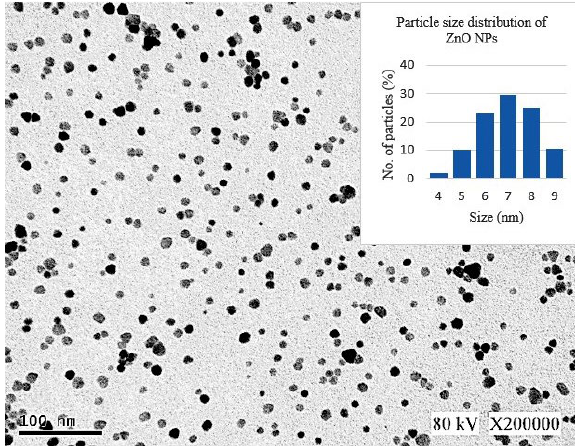
Figure 2. ZnO NPs image under transmission electron microscope (TEM) and particle size distribution of ZnO